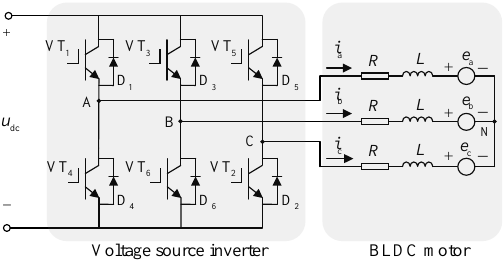
Figure 1. Equivalent circuit of a brushless DC (BLDC) motor drive system.